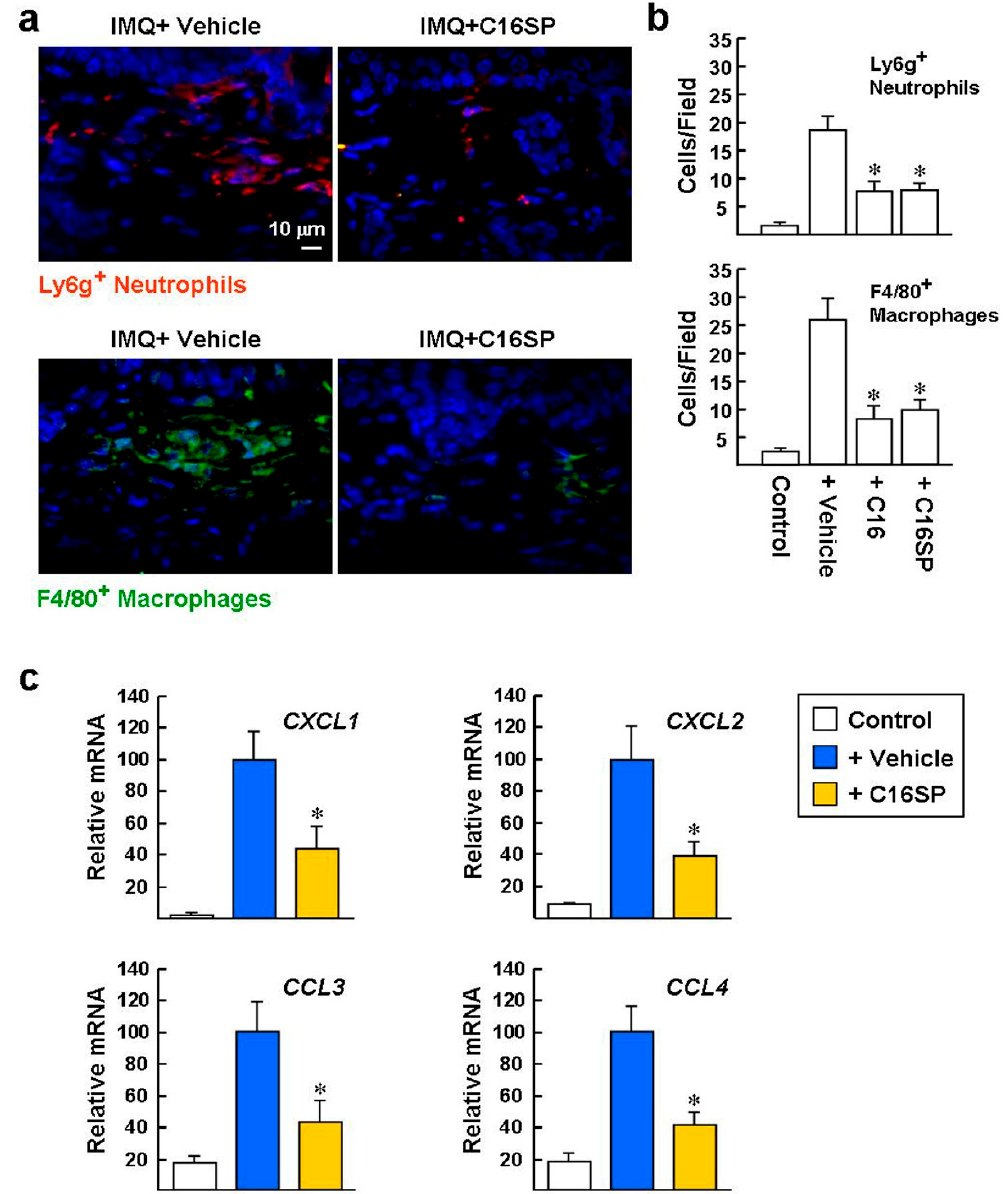
Figure 7. C16 and C16SP suppress IMQ-induced neutrophil and macrophage infiltration. ( a , b ) Mice dorsal skins were treated with IMQ cream plus vehicle, C16, or C16SP for six consecutive days. Immunofluorescence analysis of the levels of Ly6g + neutrophils ( red ) and F4 / 80 + macrophages ( green ). Nuclei were visualized with Hoechst 33258 staining. Representative images are from six sections per mouse skin, with six mice per group. The digital image analyses of Ly6g + and F4 / 80 + cells were performed blinded on an average of 6 randomly selected 1000 × magnification fields from each section, using a Zeiss epifluorescence microscope and Zeiss software. Control indicates mice which received cream without IMQ. * p < 0.002 versus IMQ / vehicle-treated group. ( c ) Murine dorsal skins were treated with IMQ cream plus vehicle or C16SP for four consecutive days. Real-time qPCR analysis of the levels of chemokines. Gapdh was used as a loading control. Data are from three independent experiments. * p < 0.05 versus IMQ / vehicle-treated group.